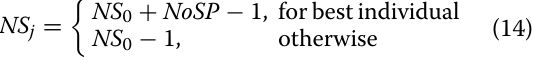
Fig. 4 The overall implementation procedure of dynamic reconfiguration for a TEG system via ACS